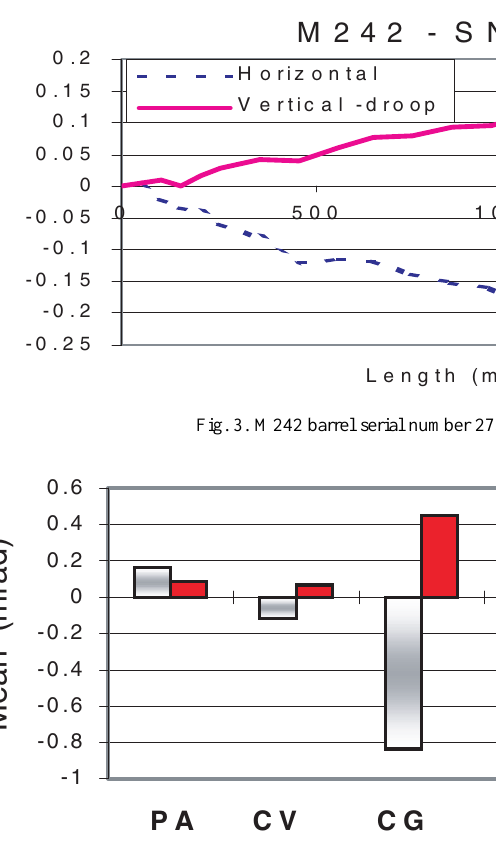
Fig. 4. The 25-mm XM881 means of jump